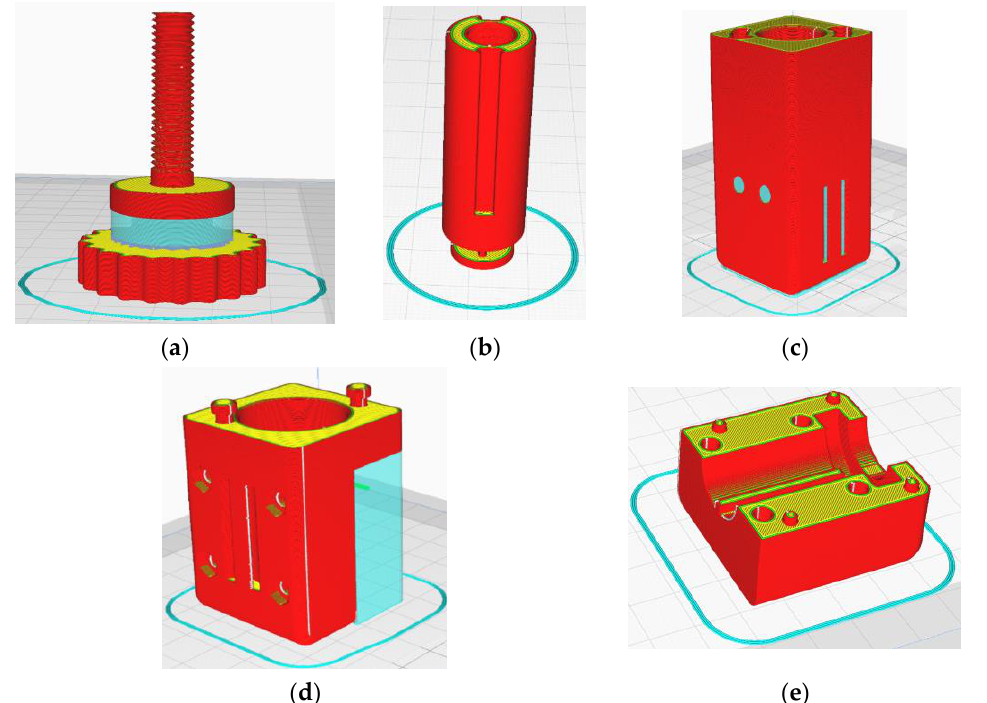
Figure 7. Print simulation in Cura of: ( a ) Rotating Lever; ( b ) Piston with seal; ( c ) Shell; ( d ) Shell Connection; ( e ) Shell Split.